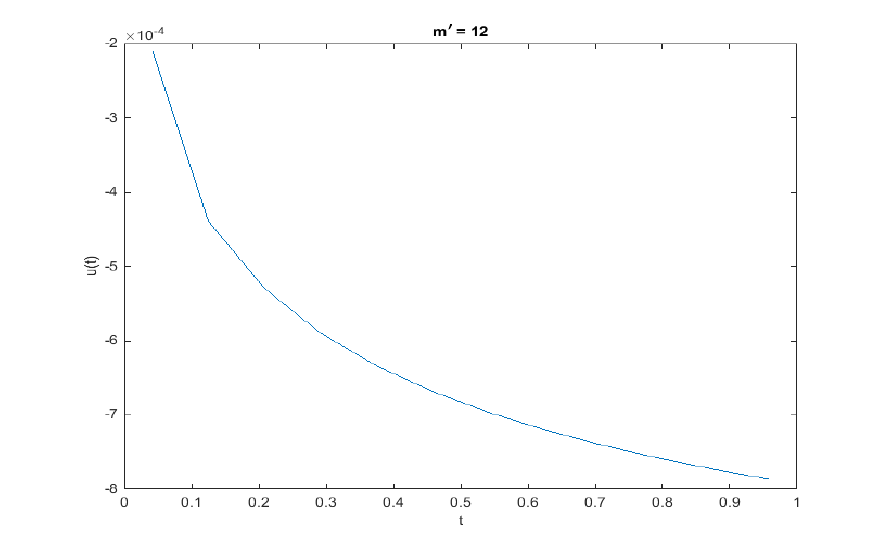
Figure 2. Error plot for Example 2 with